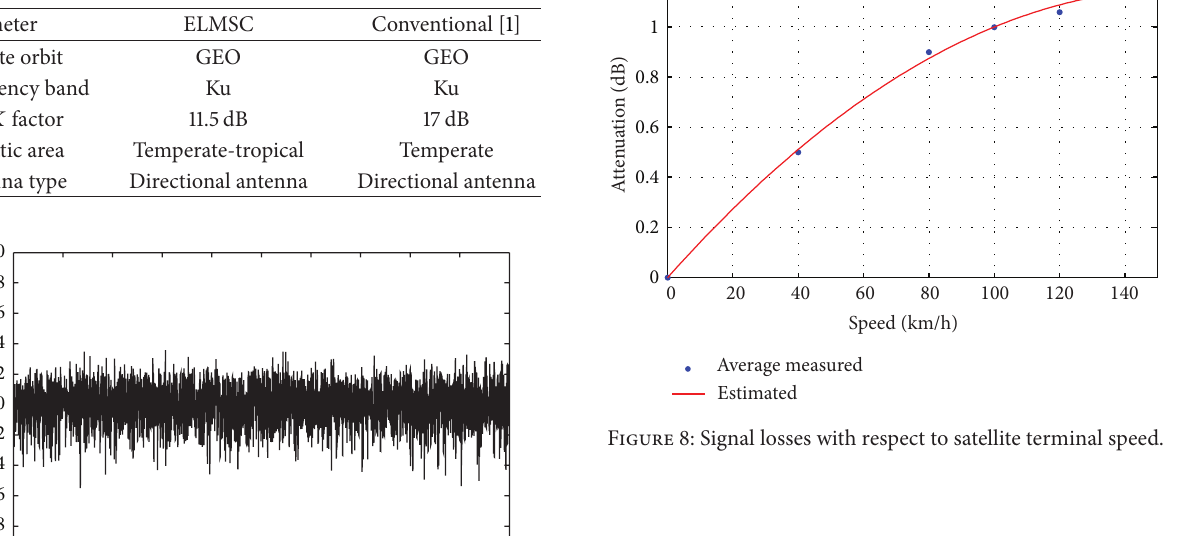
Table 4: Models’ parameters.